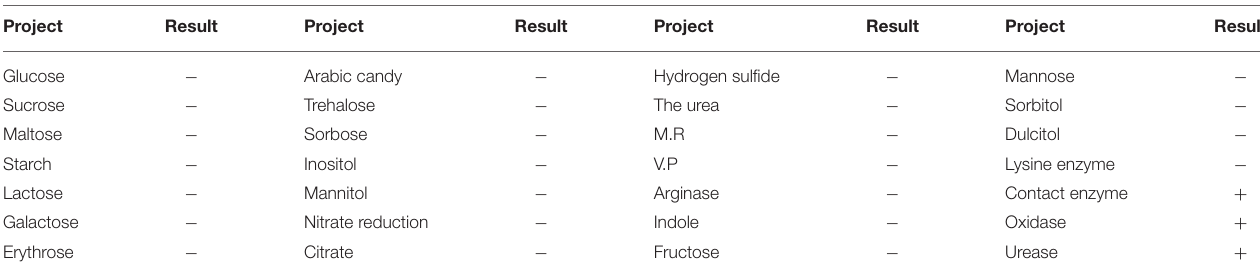
TABLE 2 | The results of biochemical test of isolated strains.